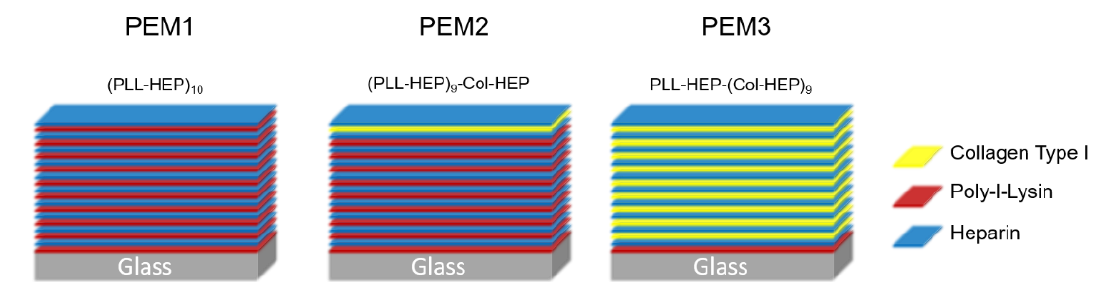
Figure 1. Architecture of the investigated LbL